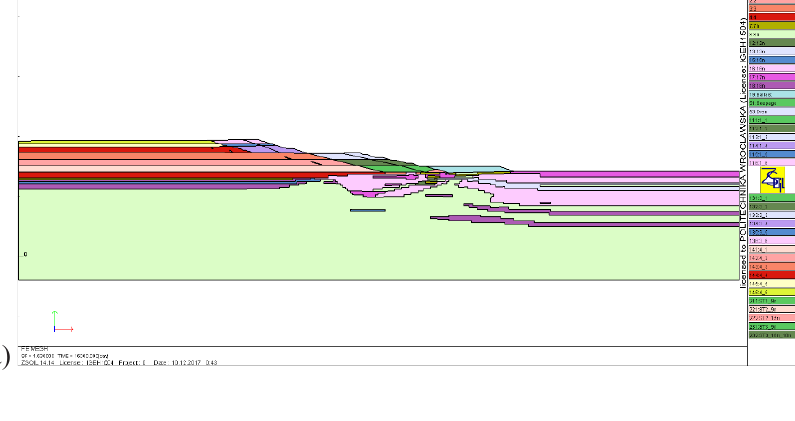
left edge within the sediments, and also partially on